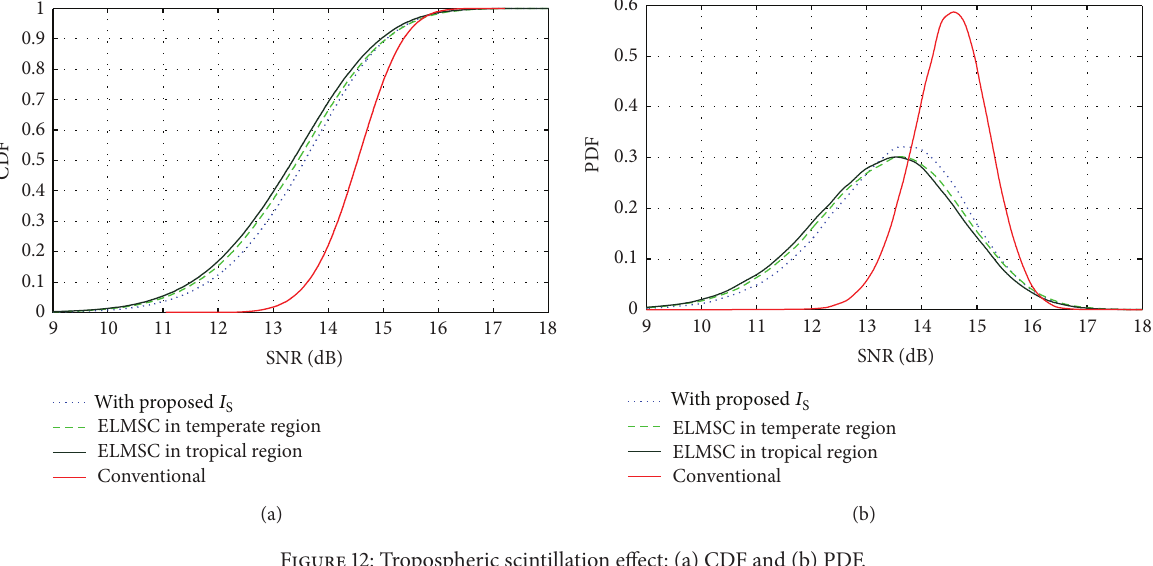
the tropospheric scintillation effect for several fade depths at different 𝑃